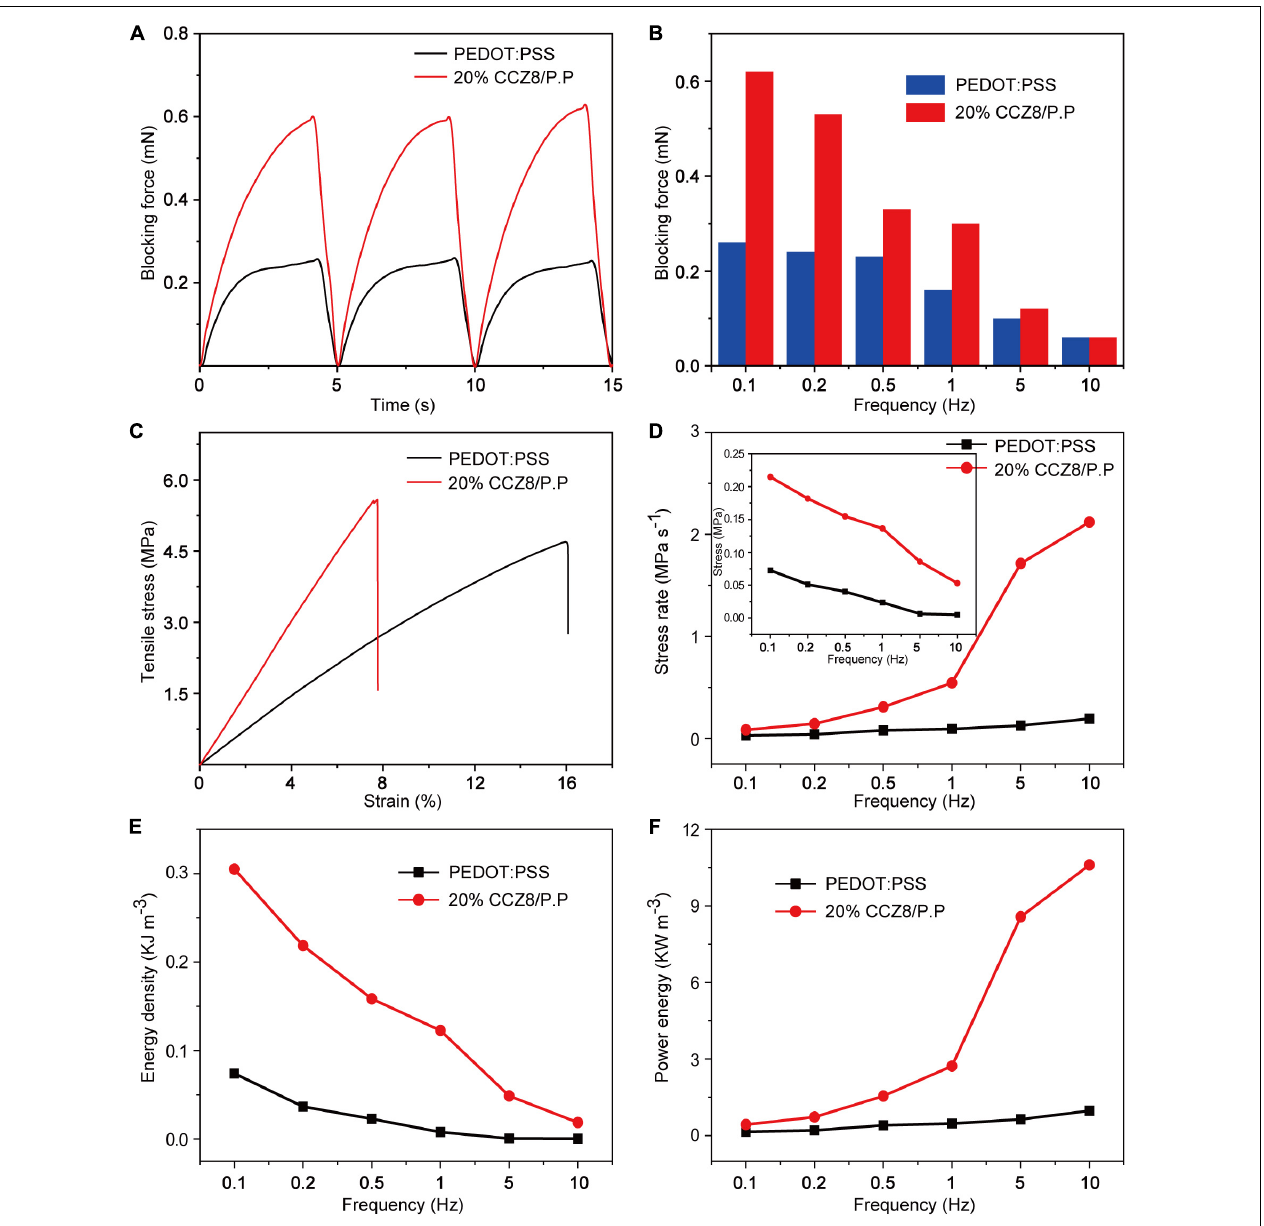
FIGURE 7 | Actuation performances of PEDOT:PSS and 20% CCZ8/P.P textile actuator. (A) Time-dependent blocking forces at 0.1 Hz. (B) Frequency-dependent blocking forces. (C) The tensile stress-strain curves. (D) Frequency-dependent stress rates. Inset: frequency-dependent stress. (E) Frequency-dependent energy densities. (F) Frequency-dependent power